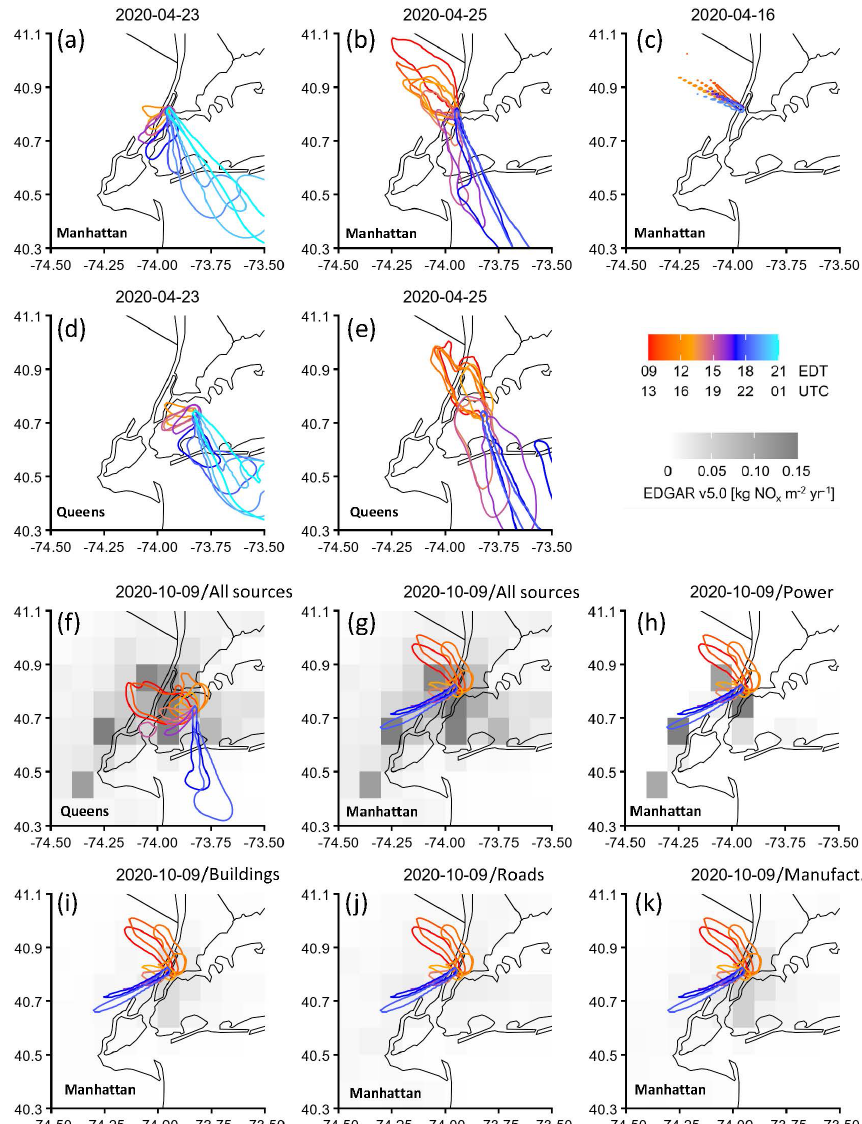
Figure 9. Twenty-four hour total STILT surface influence contours for total column NO 2 exceedances on 23 April (a, d) , 25 April (b, e) , and 9 October (f–k) and a low NO 2 case on 16 April 2020 (c) , for comparison. Contour lines represent surface influence of 1ppb (µmolm − 2 s − 1 ) − 1 and are colored by hour-of-day of the receptor. October 9 is overlaid with EDGAR inventories of NO x for 2015 (kgNO x m − 2 yr − 1 ). The area encircled by each contour indicates the region of emissions that reaches the Manhattan and Queens obser- vation sites for a given time and